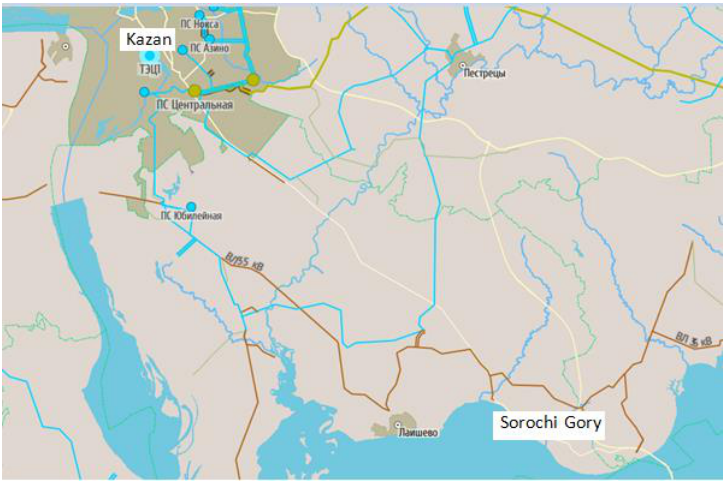
Figure 4. Map presenting the grid over Tatarstan